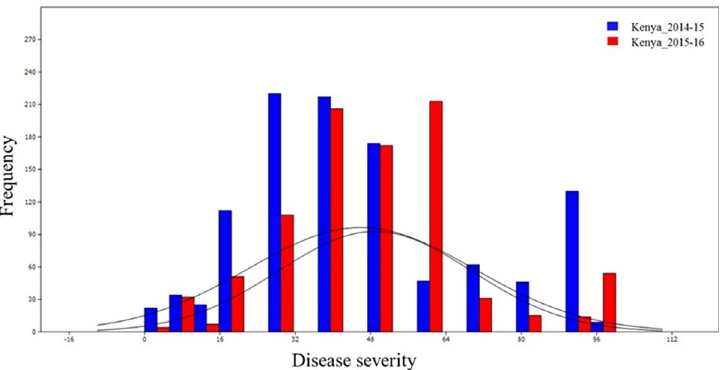
Fig 2. Graph showing the frequency distribution of Mexican bread wheat landraces for Stem Rust (SR) disease severity score in Kenya during 2014–15 and 2015–16. Disease severity score plotted on X-axis and frequency on Y- axis,